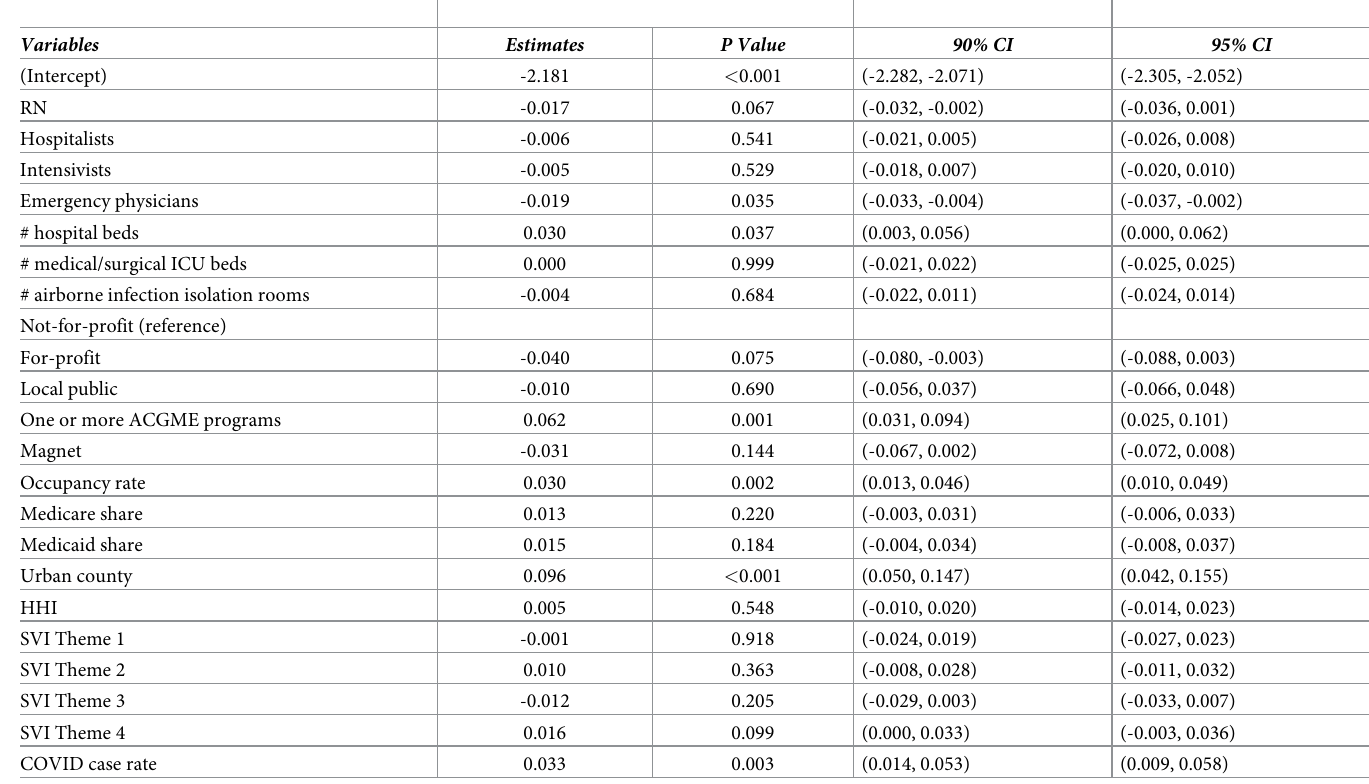
Table 2. Parameter estimates quantifying the association between RSERs and hospital- and county-level variables.